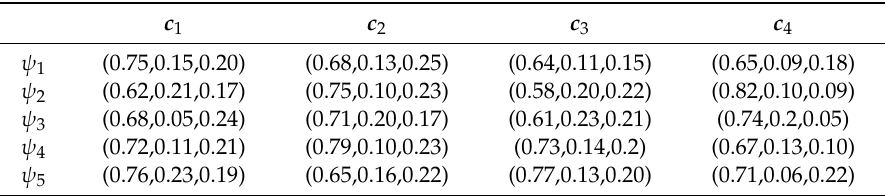
Table 1. Decision-making